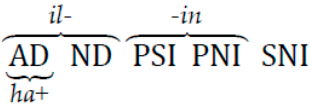
Figure 12. Reference Hierarchy for Najdi varieties.